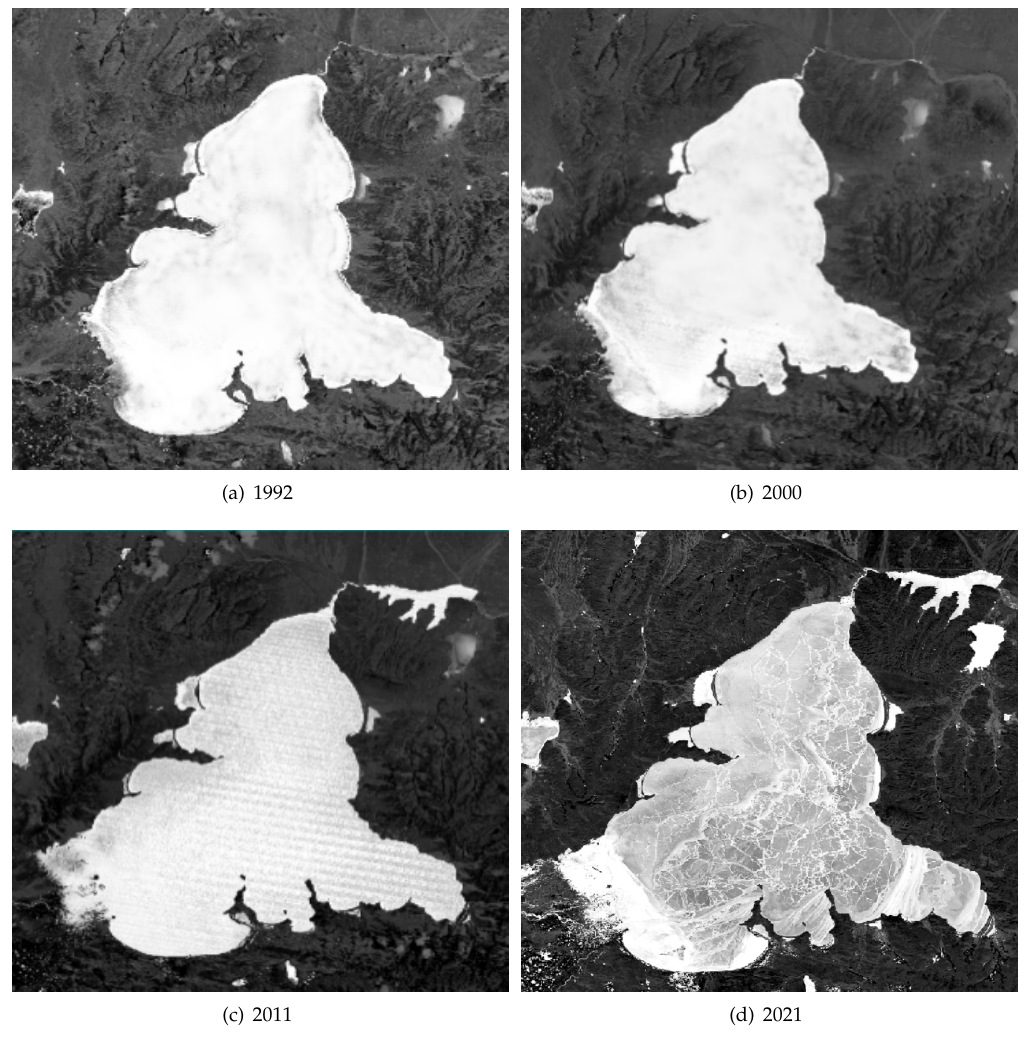
Figure 5. Water body extraction by NDWI